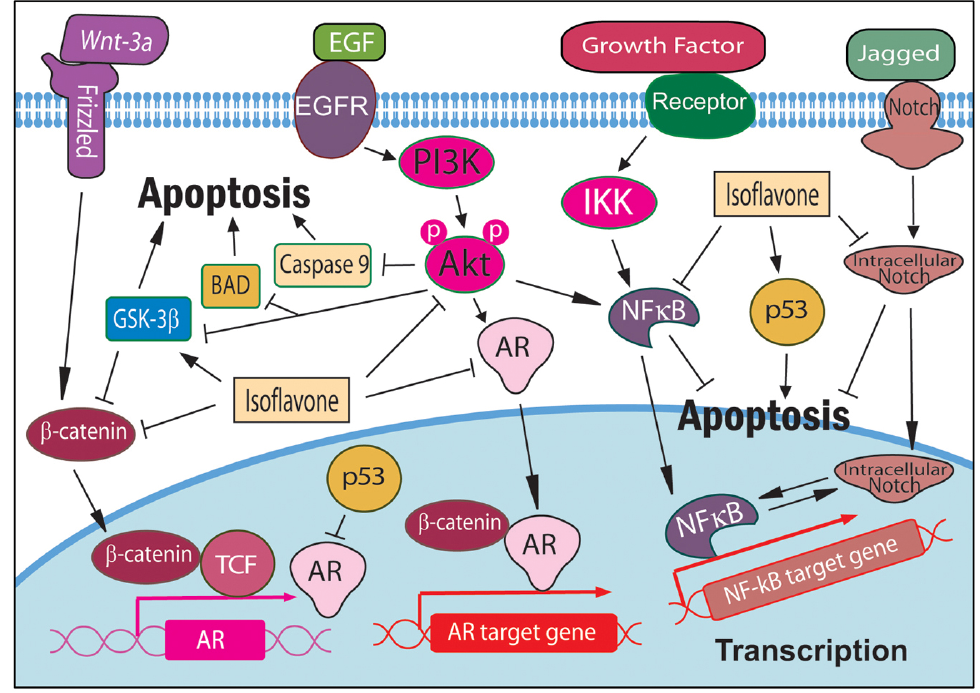
Figure 1. Cellular signaling pathways involved in the induction of apoptosis by